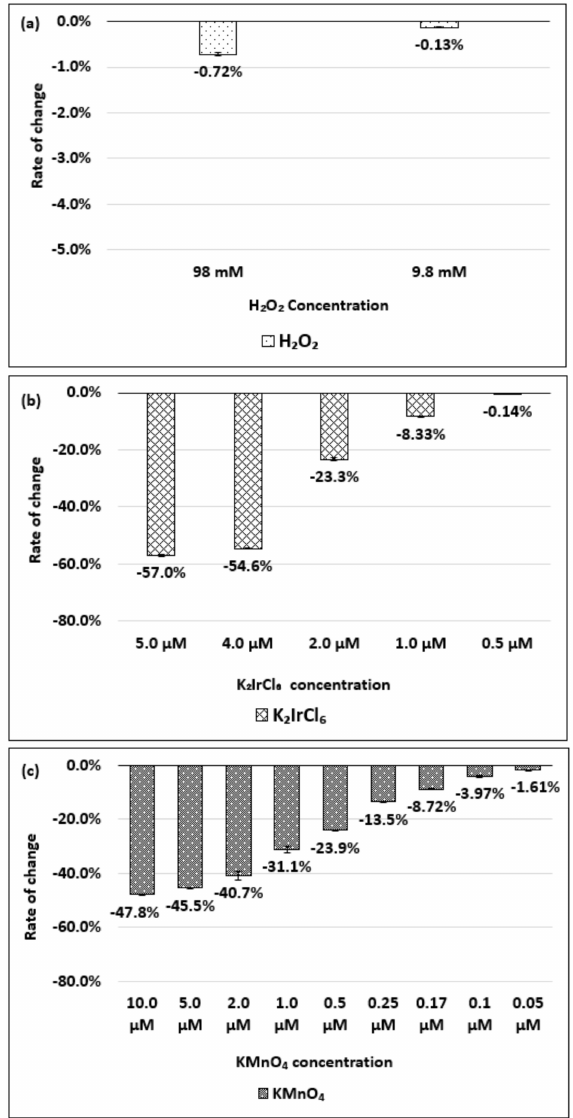
Figure 4. Absorbance change for the dsDNA-(6,5)-enriched SWNT complex, relative to the initial state, based on the concentration of ( a ) H 2 O 2 , ( b ) K 2 IrCl 6 , and ( c ) KMnO 4 added. The data are presented as the average of three independent